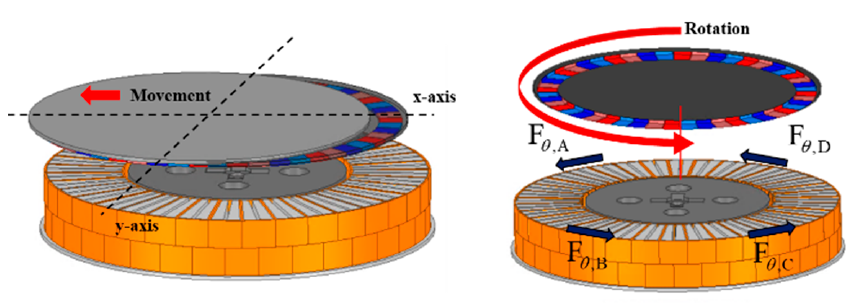
Figure 10. Principle of X–Y axis movement.